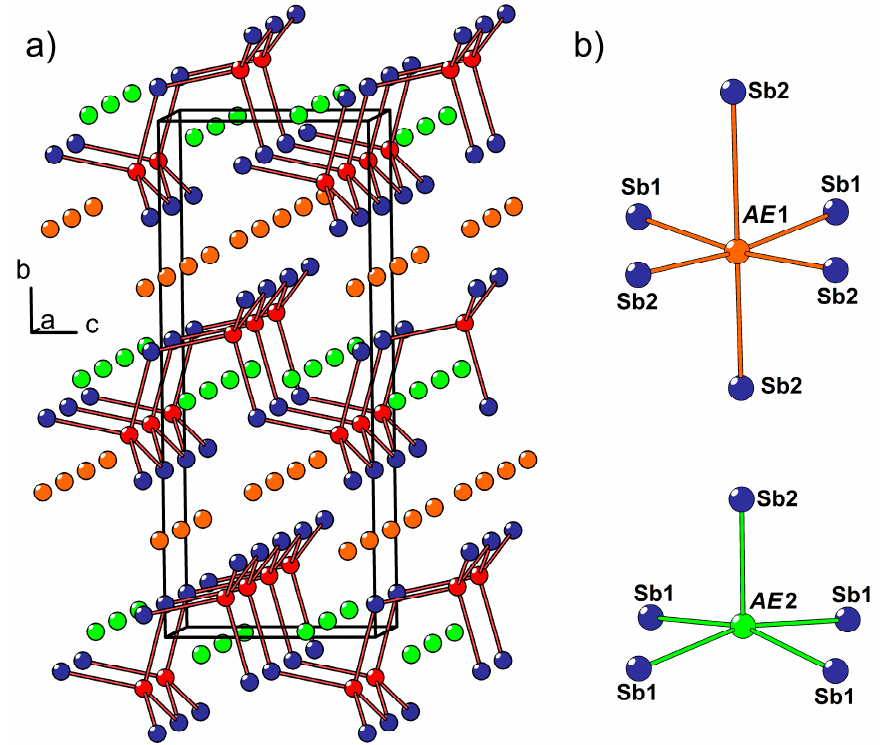
Figure 2. ( a ) Crystal structure of the Ca 2 − x Eu x CdSb 2 solid solution. The AE 1, AE 2, Cd, and Sb atoms are shown in orange, green, red, and blue, respectively; ( b ) coordination environment of the AE 1 and AE 2 atoms.